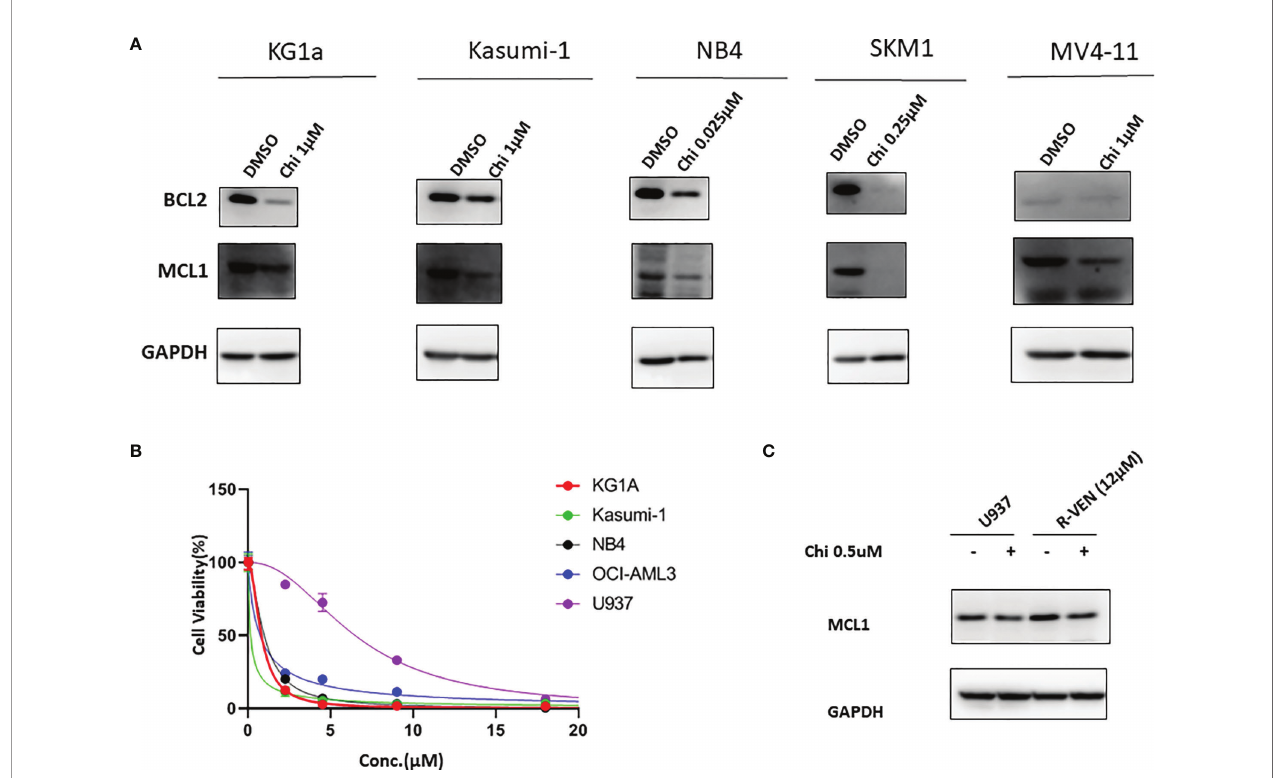
FIGURE 2 | Western blot for BCL2 and MCL1 from chidamide-treated AML cell lines. (A) . Effect of chidamide (Chi) treatment on the protein expression of BCL2 and MCL1 in different AML cell lines. All the cell lines were treated with a suitable concentration of chidamide for 72 hours, and GAPDH was used as an internal control. (B) . Venetoclax inhibited cell proliferation in different AML cell lines. All AML cell lines were exposed to different concentration of venetoclax (5 µM, 10 µM, 15 µM and 20 µM) for 72 h, and then cell viability was determined by a CCK-8 assay. (C) . MCL1 protein levels were detected by western blot after 24 h of chidamide (0.5 µM) treatment or not. R-VEN (12 µM), U937 cell line resistant to 12 µM